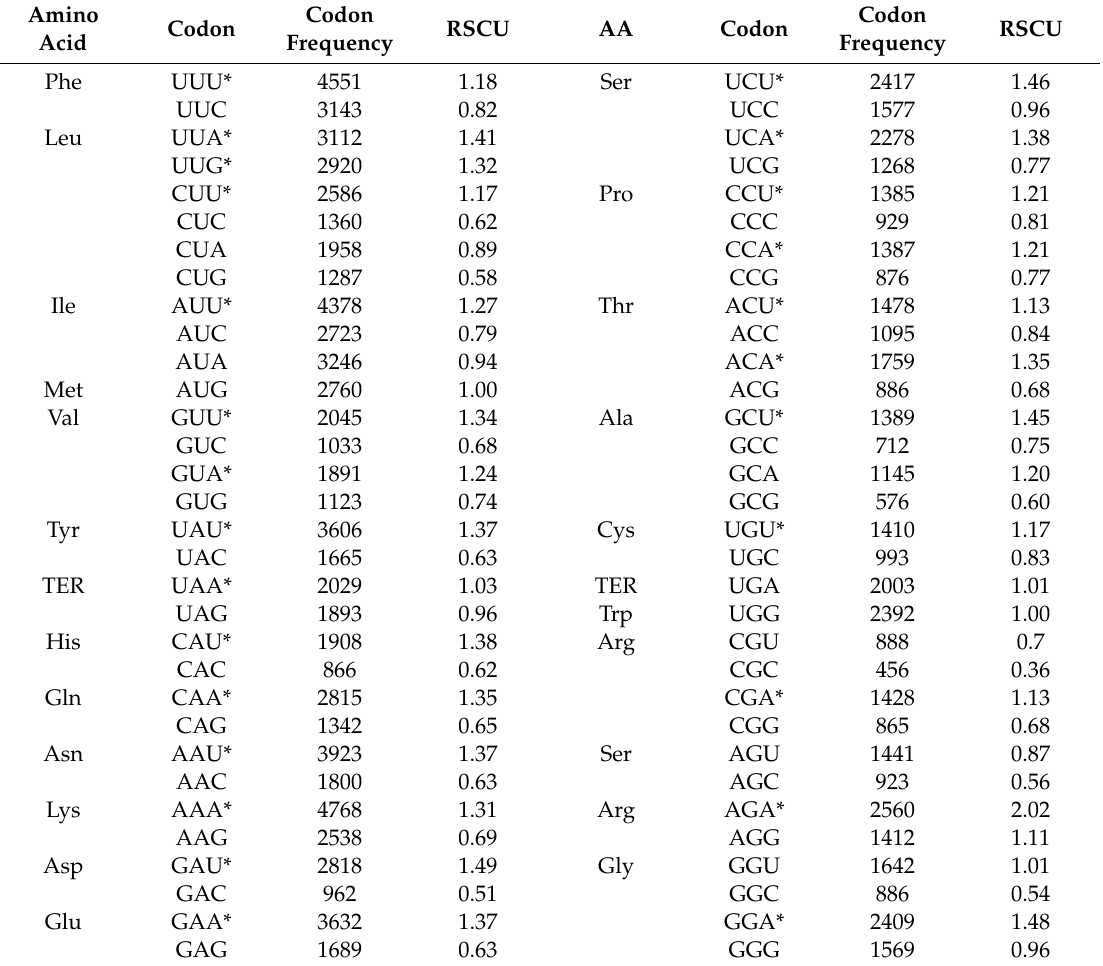
Table 2. Putative preferred codons in the P. granatum cp genome. RSCU = relative synonymous codon